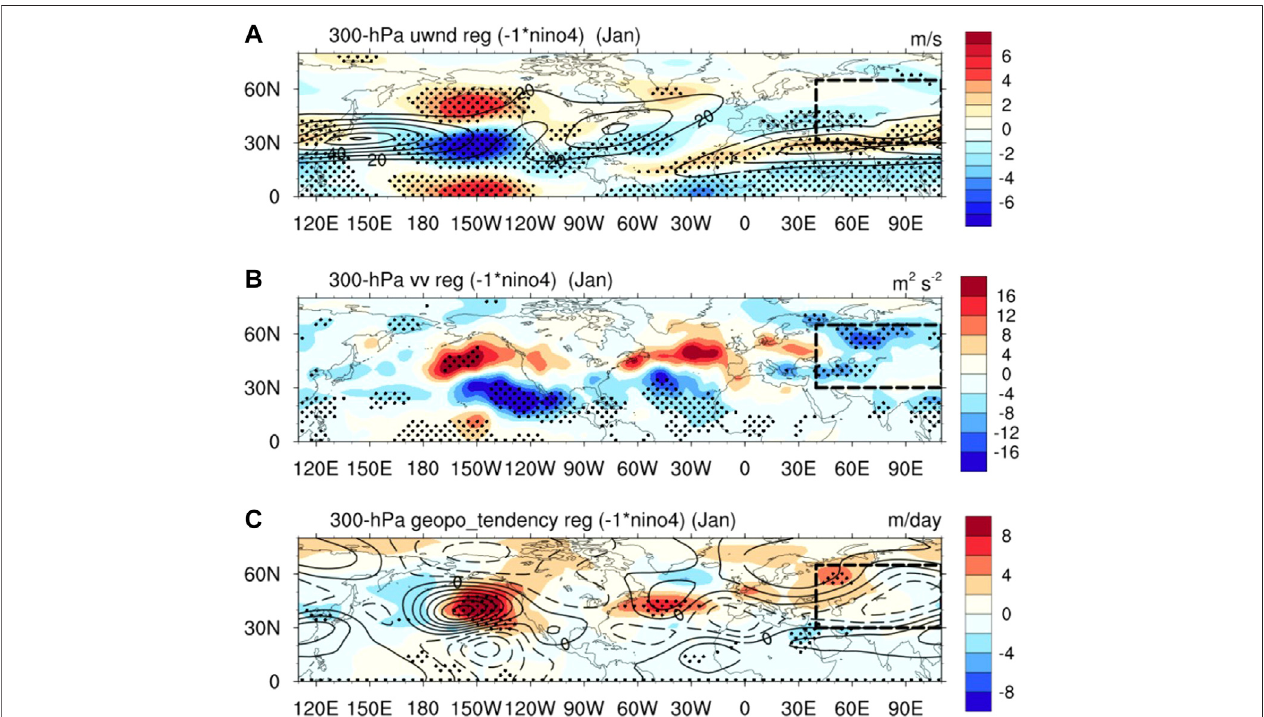
FIGURE 9 | (A) Regression of January 300 hPa zonal wind onto the − Niño4 (shading; m s − 1 ) and the climatological January 300 hPa zonal wind (contours; m s − 1 ) fortheperiod1980 – 2018 (B) RegressionofJanuary300 hPaSTEAontothe − Niño4(shading;m 2 s − 2 )fortheperiod1980 – 2018 (C) RegressionoftheJanuary300 hPa eddy-induced geopotential height tendency (shading; m day − 1 ) and geopotential height (contours; m) onto the − Niño4 for the period 1980 – 2018. In (C), zero contours areomittedandnegativevaluesaredashed.TheblackdashedboxesshowtheregionofCA;anomaliessigni fi cantatthe95%con fi dencelevelaredenotedbydots, as estimated by the Student ’ s t